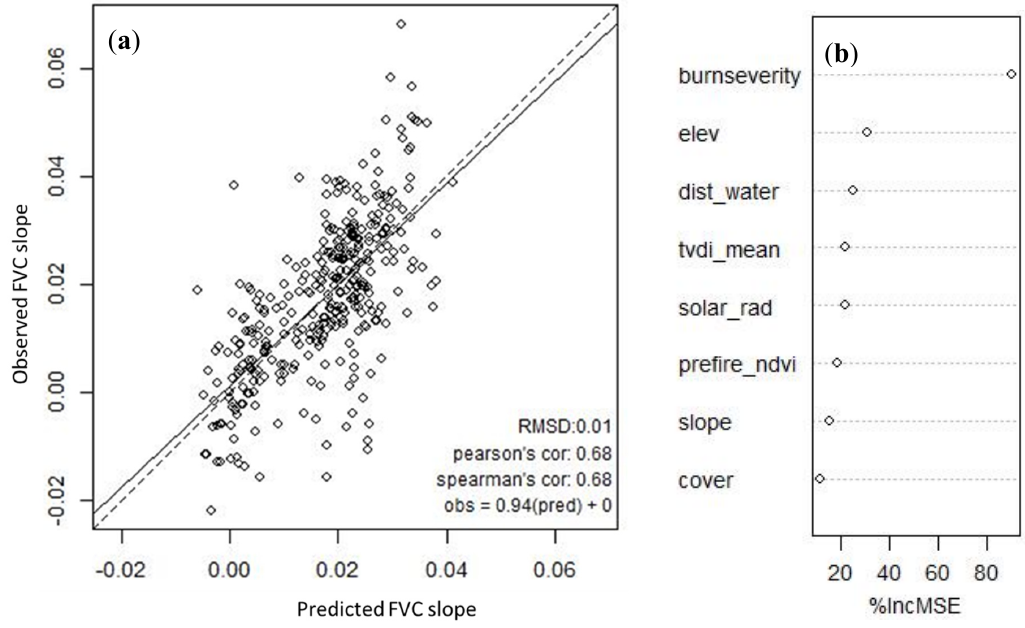
Figure 8. Observed and estimated FVC based vegetation recovery rate (or FVC slope) using the random forest algorithm ( a ) and the importance of predictors in classifying recovery rates ( b ). The dashed line is the 1:1 relationship and the solid line shows the linear best-fit between the observed and predicted vegetation recovery rate (the FVC slope) using the random forest (RF) algorithm. Variable importance measures the increase of mean square error (MSE) in the classification of the response variable if one predictor is excluded from the model.